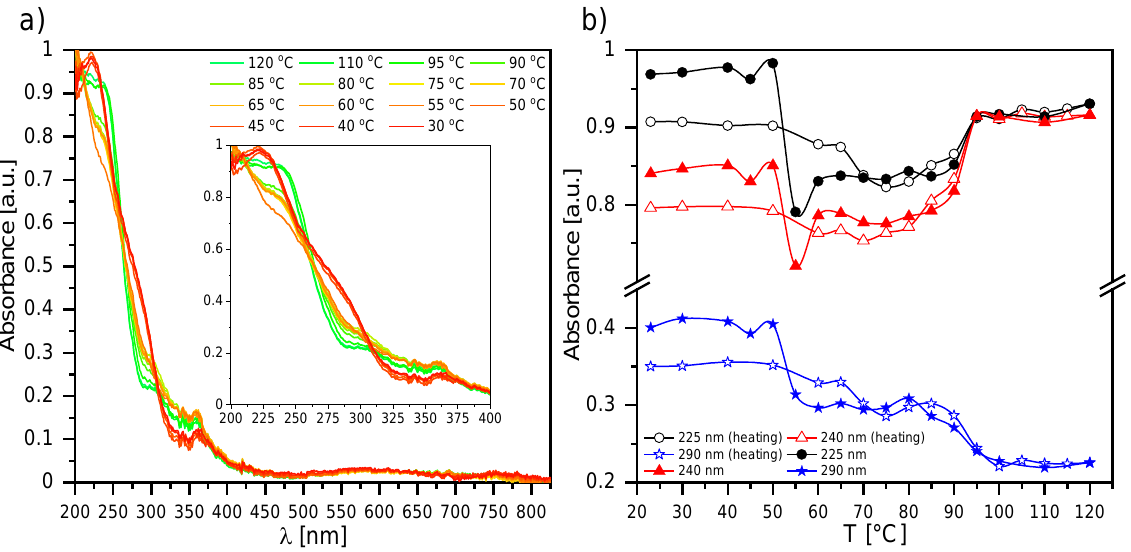
Figure 2. Solid state UV-vis absorption spectra of Composite 1 (pure EHPDB) at several chosen temperatures in the 200–850 nm range during cooling ( a ), and temperature dependence of the absorbance at around 225, 240 and 290 nm ( b ). The inset in graph ( a ) presents an enlarged region of 200–400 nm.